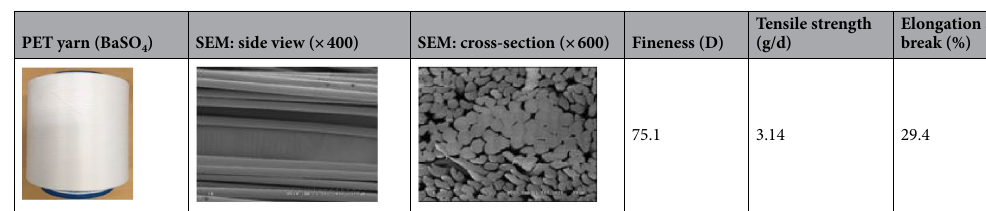
Table 1. Characteristics of a PET fiber containing barium sulfate.